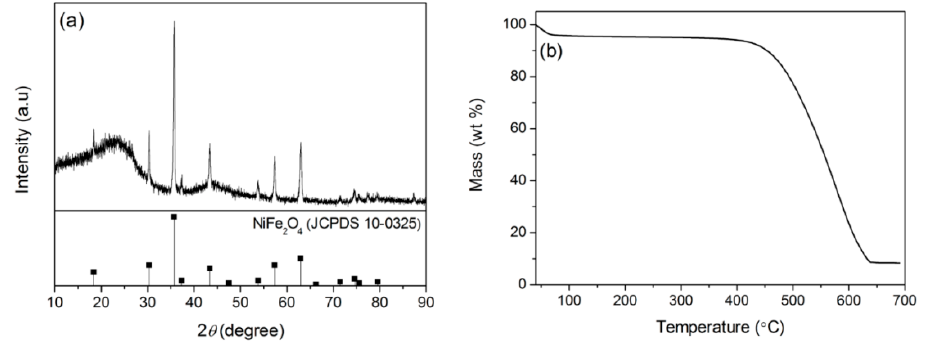
Figure 9. XRD pattern ( a ) and TG curve ( b ) of NiFe 2 O 4 /carbonized hemp fibers.